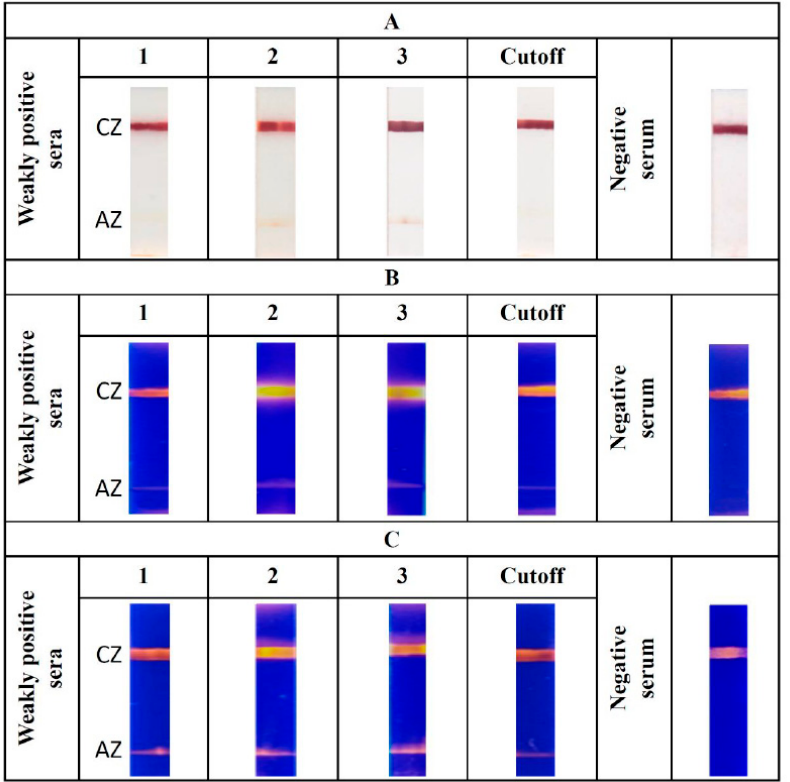
Figure 4. Results of immunochromatographic serodiagnostics of cattle brucellosis using the GNP-(protein G) conjugate ( A ); using the QD-(protein G) conjugate ( B ); and using the signal amplification with the QD-(protein G) conjugate ( C ). AZ—analytical zone; CZ—control zone.